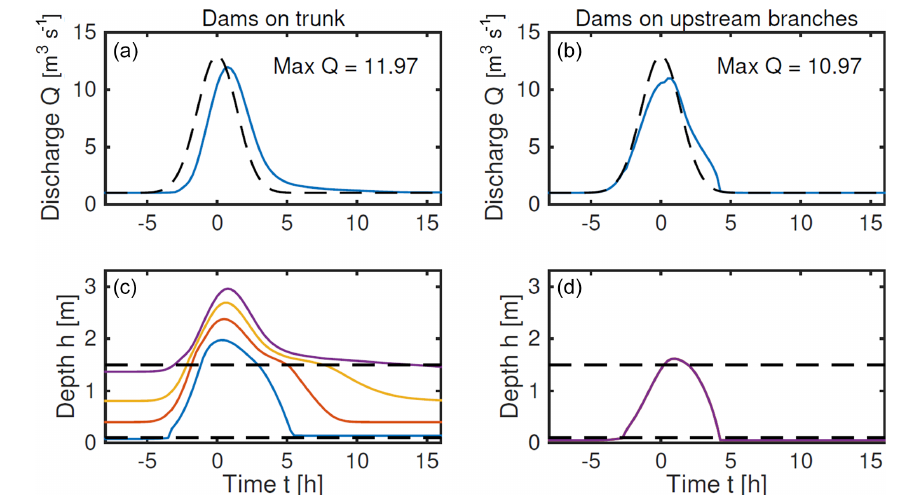
Figure 7. Solutions for the 2D network as in Fig. 2c, forced by uniform inflow to each of the eight branch nodes q(t) = q 0 + q max exp ( − t 2 /σ 2 ) , with q 0 = 0 . 125m 3 s − 1 , q max = 1 . 5m 3 s − 1 and σ = 2h. Panels (a, b) show the discharge downstream (node 4), and panels (c, d) show the water depth at the four dams (nodes 1–4) for the case on the left and the identically behaving nodes 5, 6, 9 and 10 for the case on the right. Parameter values are as given in Sect. 2.3, together with λ = 20, b = 0 . 1m and H = 1 . 5m.